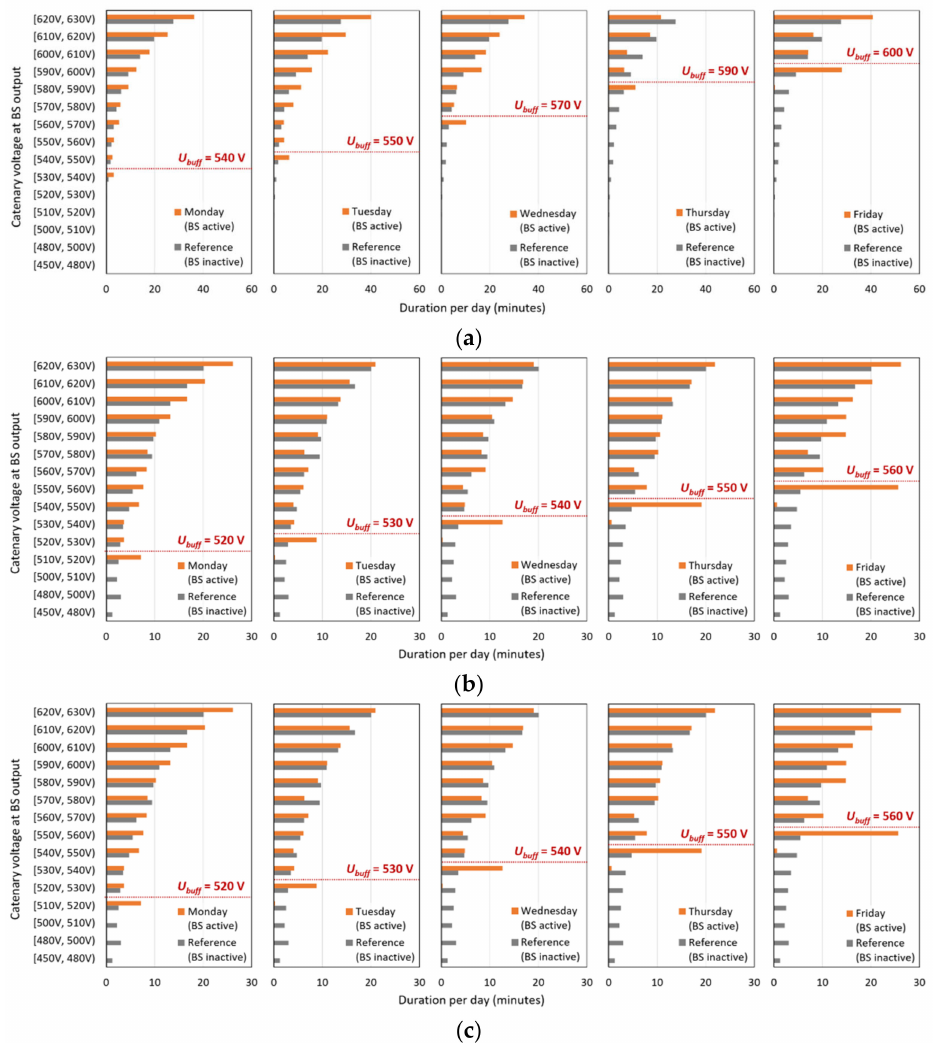
Figure 5. Histograms of buffer station output voltage for: ( a ) week 2—normal supply, battery-assisted trolleybuses in operation; ( b ) week 4—disconnected feeder 40, standard trolleybuses in operation; ( c ) week 6—disconnected feeder 40, feeder 41 supplied from remote substation MR1-Hydro, standard trolleybuses in